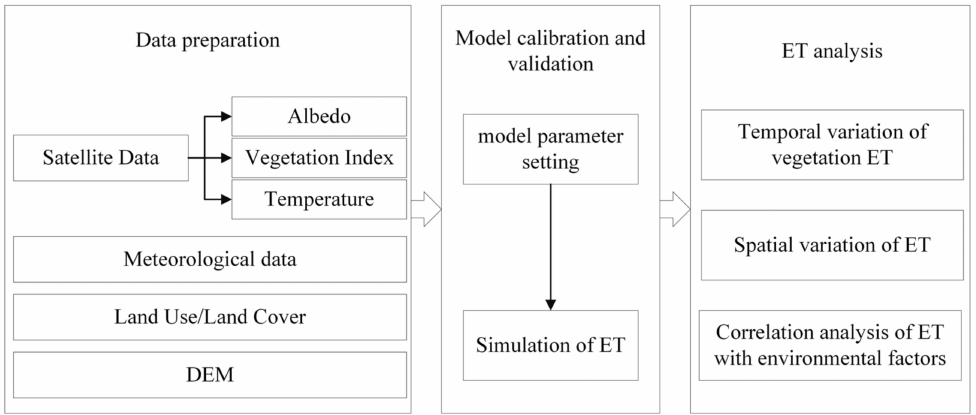
Figure 2. Flow chart of the research